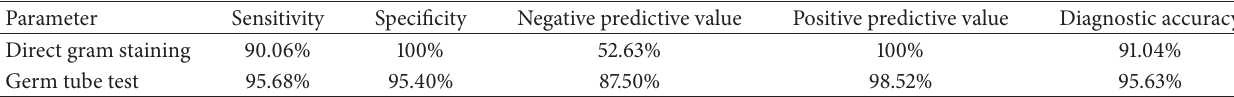
Table 3: Sensitivity, specificity, negative predictive value, positive predictive value, and the diagnostic accuracy of (a) direct gram staining